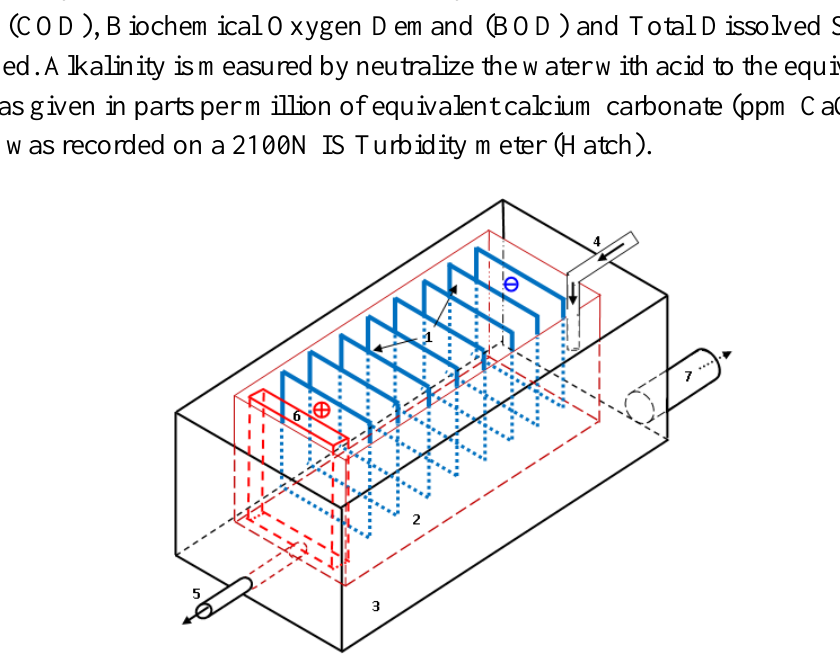
Figure 1. Schematic diagram of designed electroflotation